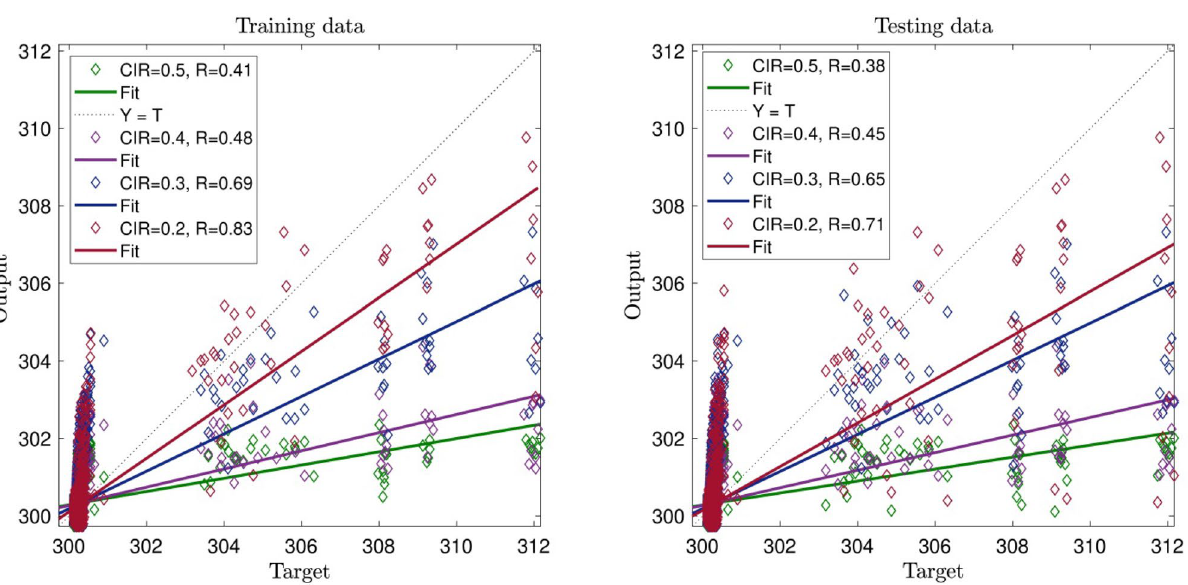
Figure 3. CIR (clustering parameter) changes in the ACOFIS learning processes when the pheromone effect is 0.2 and number of inputs is